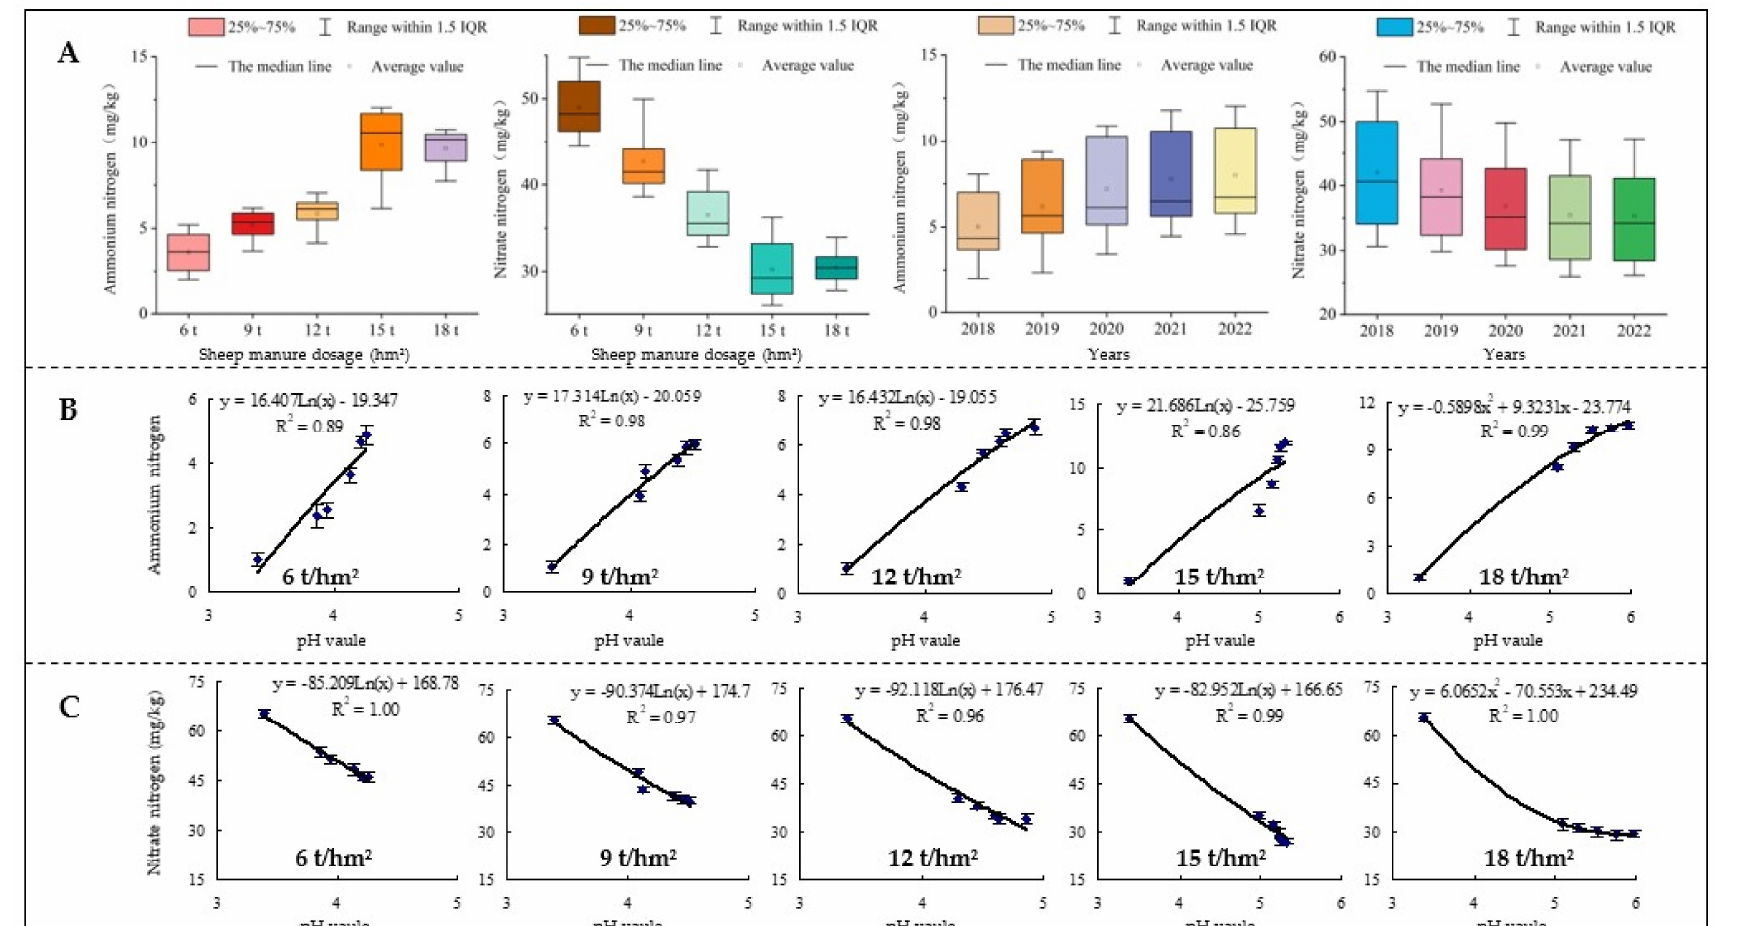
Figure 4. Effects of sheep manure fertilizer and pH value on soil ammonium and nitrate contents in tea plantation. ( A ) Effects of sheep manure fertilizer on soil ammonium and nitrate contents in tea plantation; ( B ) effect of pH value on soil ammonium nitrogen content in tea plantation after a continuous use of sheep manure fertilizer for 5 years; ( C ) effect of pH value on soil nitrate nitrogen content in tea plantation after a continuous use of sheep manure for 5